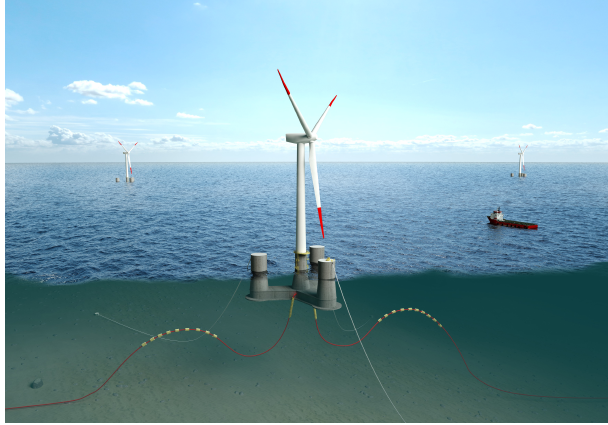
Figure 1. The OO-Star Wind Floater Semi 10 MW concept (http: //www.olavolsen.no; last access: 24 November